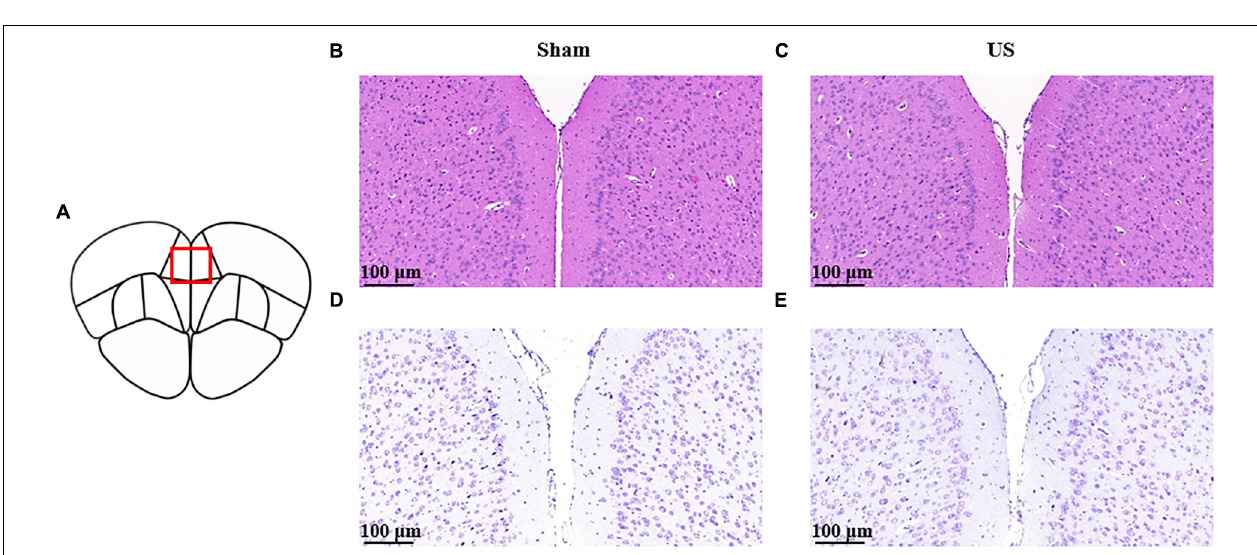
FIGURE 7 | Histological analyses of PFC brain sections for the evaluation of tissue damage in sham and US-treated mice (without LPS injection). (A) Schematic diagram of brain sections. Representative images of hematoxylin and eosin staining in sham (B) and US-treated (C) mice. Representative images of Nissl staining in sham (D) and US-treated (E) mice ( n = 3 in each group). PFC, prefrontal cortex; US, ultrasound stimulation; LPS, lipopolysaccharide.